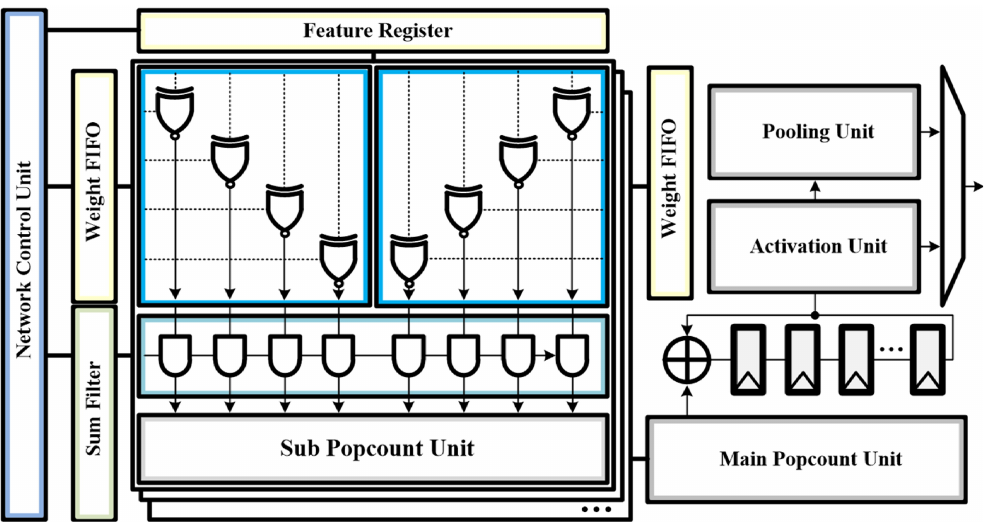
Figure 9. Block diagram of the proposed BNN